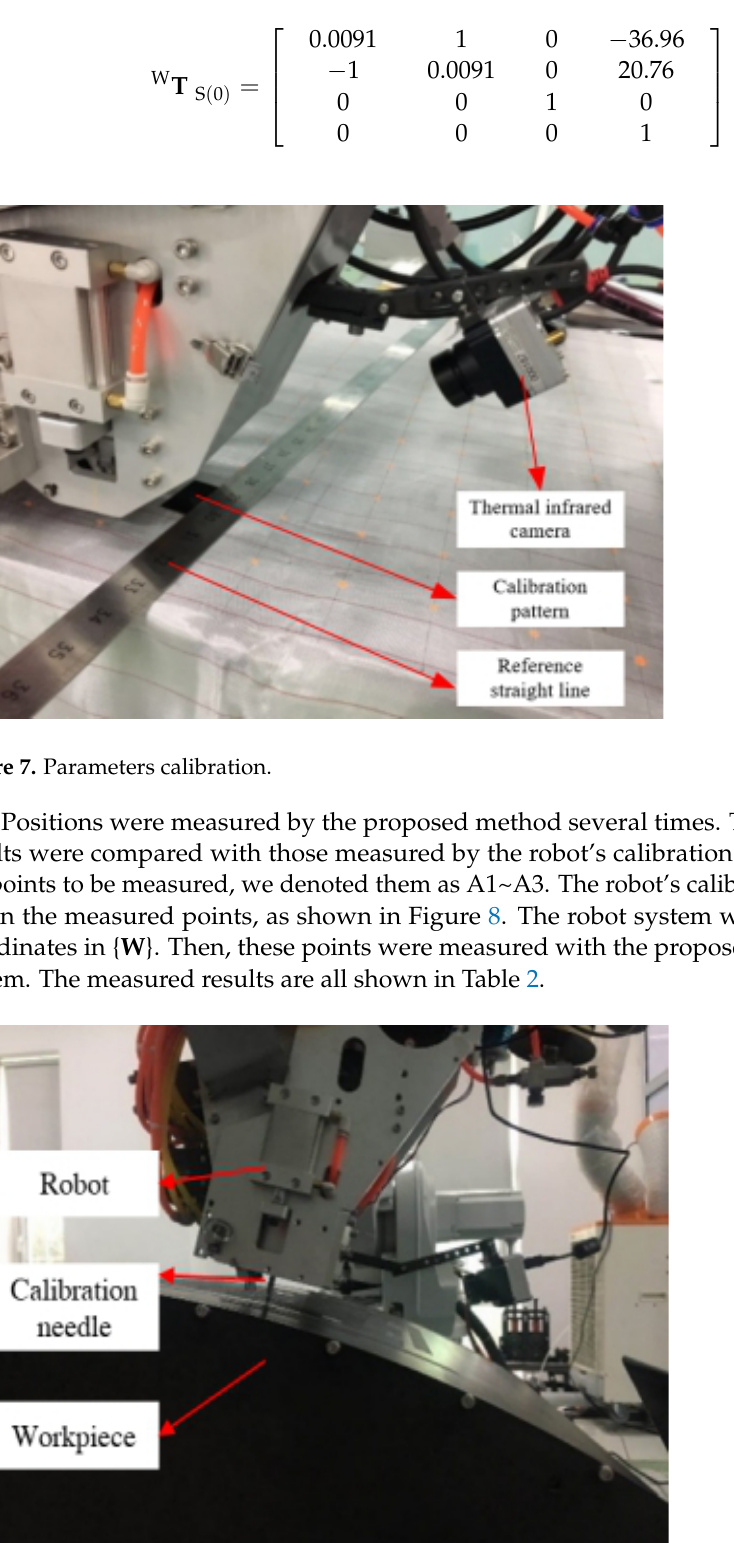
Figure 8. Position measurement. Table 2. Position measurement results of two methods.